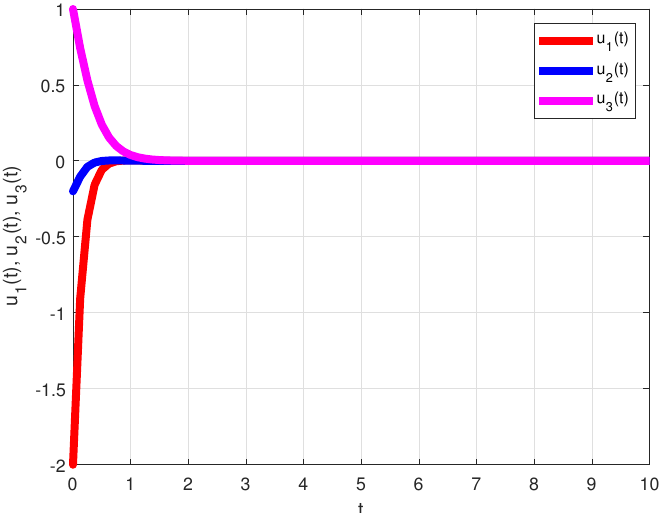
Figure 5. The time responses of the states u 1 ( t ) , u 2 ( t ) and u 3 ( t ) of system (70) for the external inputs x ( t ) = [ 0,0,0 ] T in Example